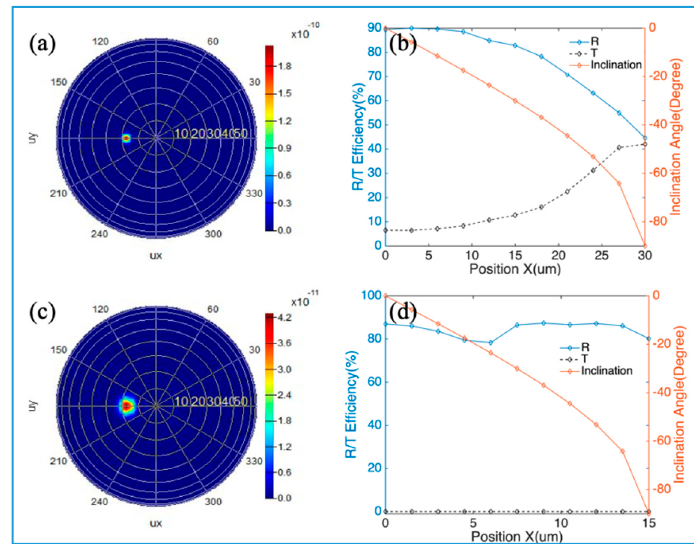
Figure 8. Large-FOV deflecting of meta-reflectors: ( a ) Intensity distribution of the reflected light in the coordinate system of inclination angle and azimuth angle. The Gaussian source is localized on the focal plane with coordinates (9 µ m, 0, 30 µ m), which is reflected by the meta-reflector with DBR in Figure 4a; ( b ) Reflectance, transmittance and inclination angle of the reflected light as a function of the x -coordinate of source on the focal plane of the meta-reflector with DBR; ( c ) Intensity distribution of the reflected light in the coordinate system of inclination angle and azimuth angle. The source is localized on the focal plane with coordinates (4.5 µ m, 0, 15 µ m), which is reflected by the meta-reflector with Au film in Figure 5a; ( d ) Reflectance, transmittance, and inclination angle of the reflected light as a function of the x -coordinate of source on the focal plane of the meta-reflector with Au